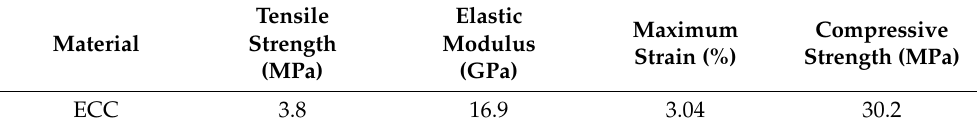
Table 6. Mechanical properties of ECC (adapted with permission from [23]; copyright 2018 Elsevier).